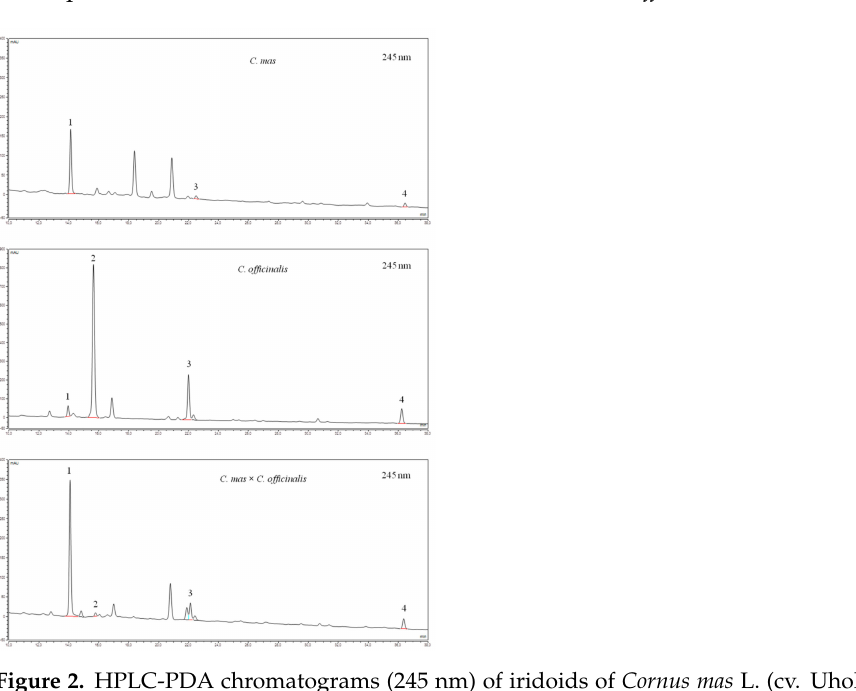
Figure 2. HPLC-PDA chromatograms (245 nm) of iridoids of Cornus mas L. (cv. Uholok), C. offic- inalis Siebold & Zucc., and C. mas × C. officinalis fruit extracts: 1—loganic acid;